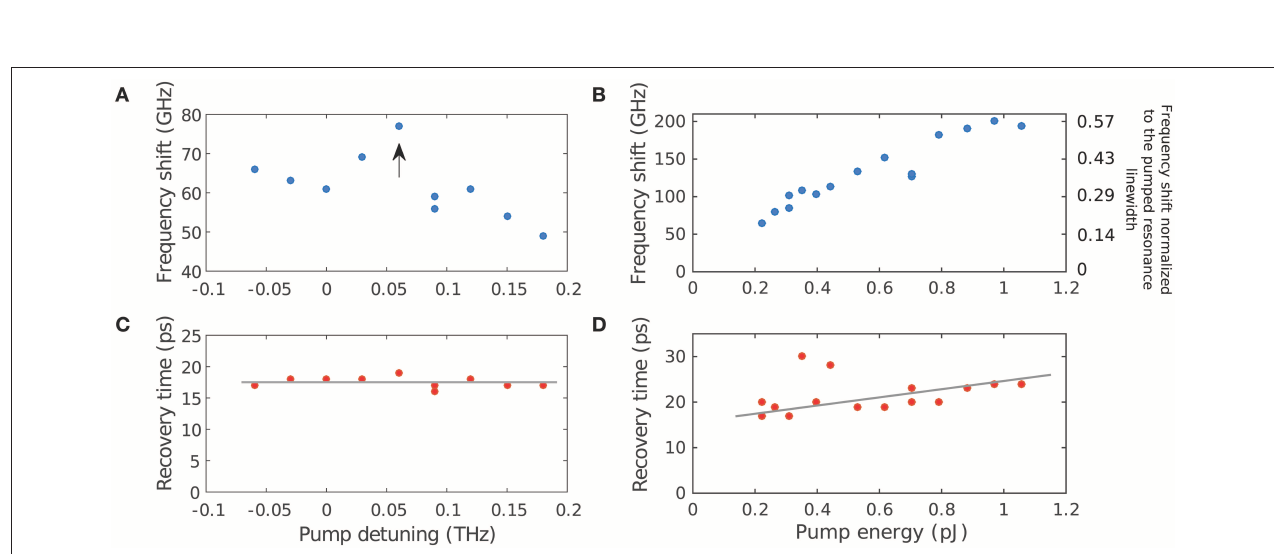
FIGURE 5 | Parametric study of the free-carrier effect in a III-V/SOI nanobeam: Non-linear spectral shift and recovery time vs. pump detuning (A–C) and vs. pump energy (B–D) . Measurements are performed with 1.4 pJ pump energy in (A–C) and with +115 GHz pump detuning in (B–D) . (A) Shows that we obtained the highest non-linear shift for a pump detuning of 60 GHz = 0.5 nm. In (B) the non-linear shift is also normalized compared to the FWHM of the pumped resonance: one can + − see that the saturation occurs for a shift reaching half of the resonance FWHM. In (C,D) gray lines indicate different tendencies of the evolution of the recovery time: no influence from the pump detuning in (C) and a slight increase with increasing energy in (D) .